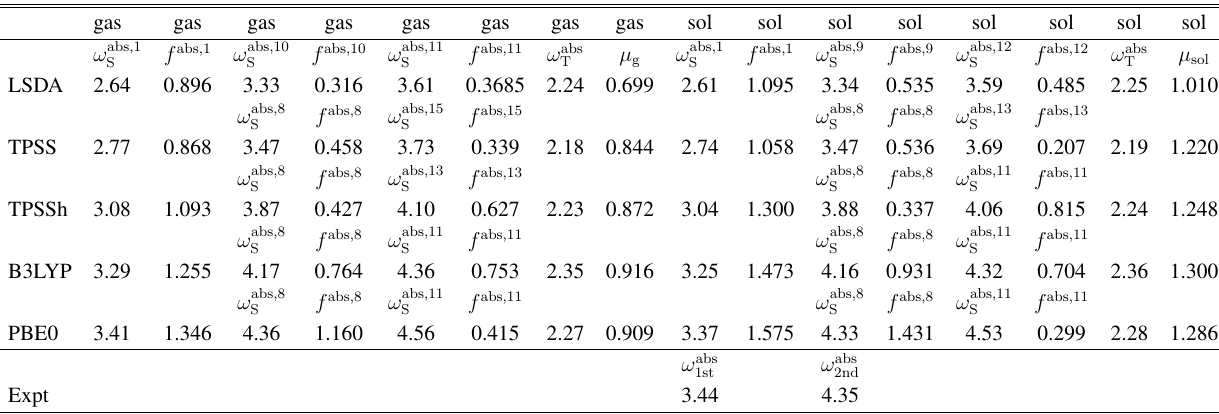
Table 12. The same as Table 11, but for BtBPQ. Experimental values measured in chloroform are obtained from Ref.